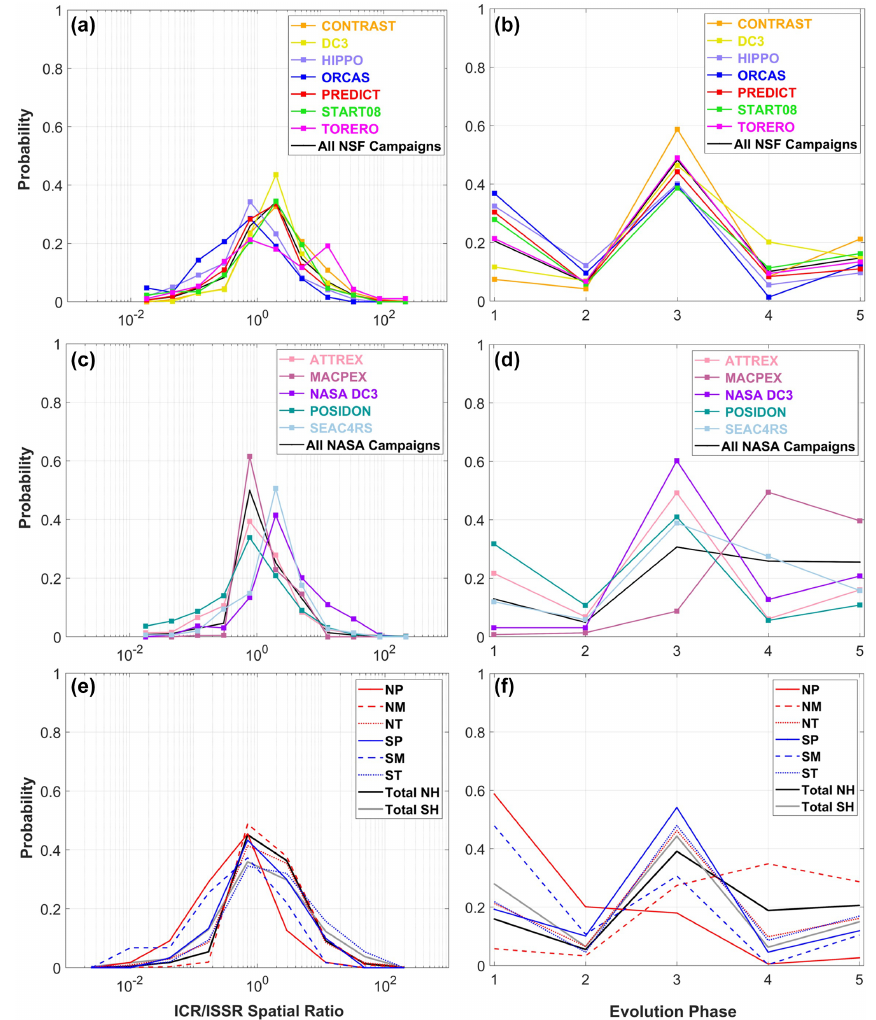
Figure 3. Probabilities of (a–c) the ICR / ISSR spatial ratio and (d–f) five evolution phases for NSF, NASA and all campaigns in row 1, 2 and 3, respectively. The probabilities are shown for each campaign (in a, b, d and e ) and for each latitudinal region (in c and f